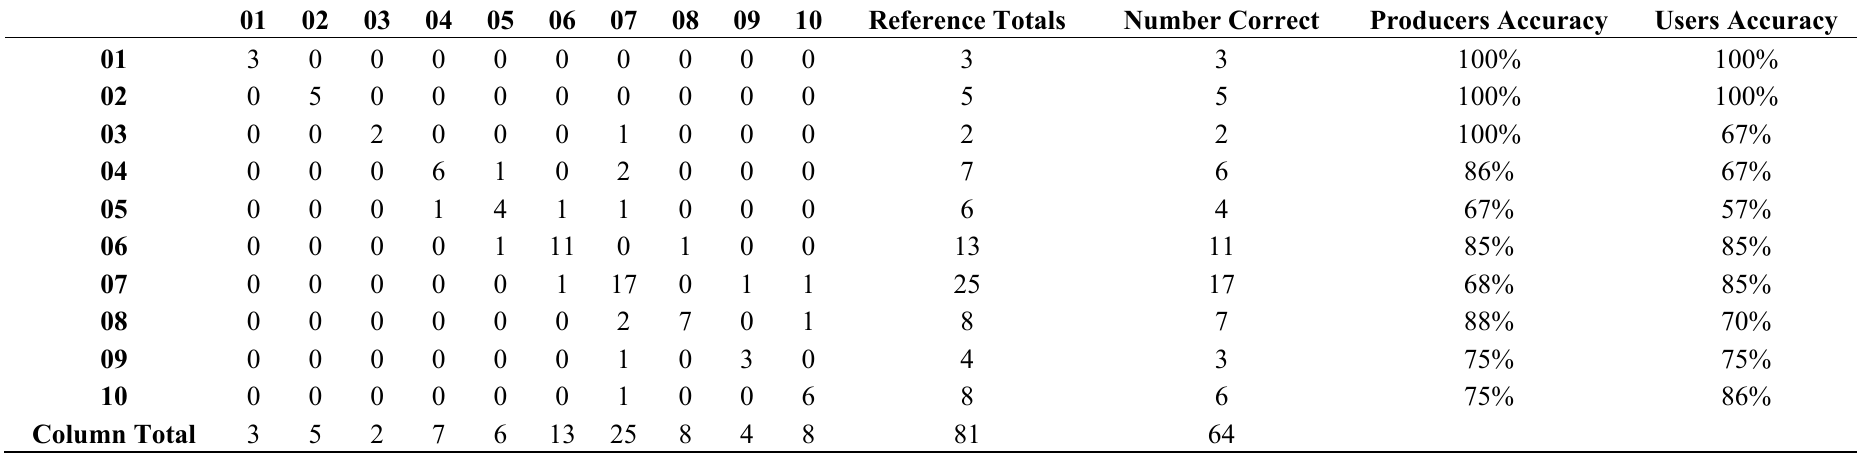
01, water bodies; 02, wetlands; 03, shrub lands/forests; 04, rainfed crops/rangelands; 05, rainfed-supplemental-chili; 06, rainfed-supplemental-cotton dominant chili; 07, irrigated-SW-rice-rice; 08, irrigated-SW-rice-pulses; 09, irrigated-SW-sugarcane-rice; 10, irrigated-SW/GW-orchards; overall classification accuracy = 79.01%; overall kappa statistics =